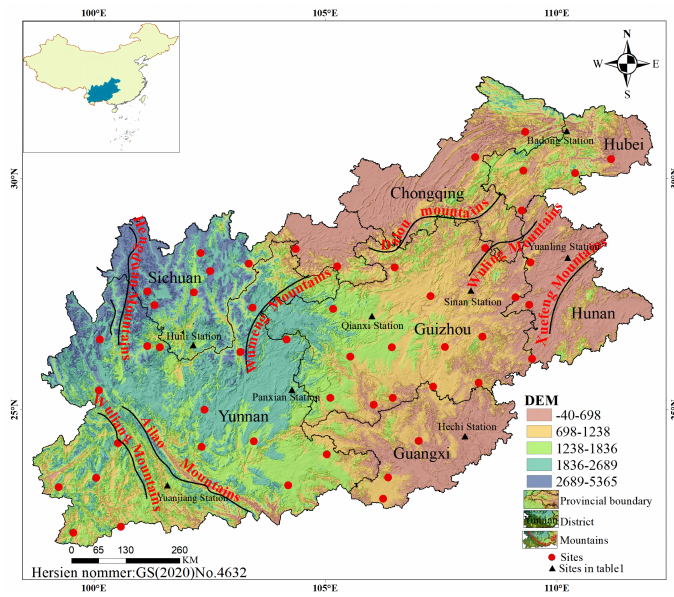
Figure 1. Distribution Map of the study area and ground precipitation